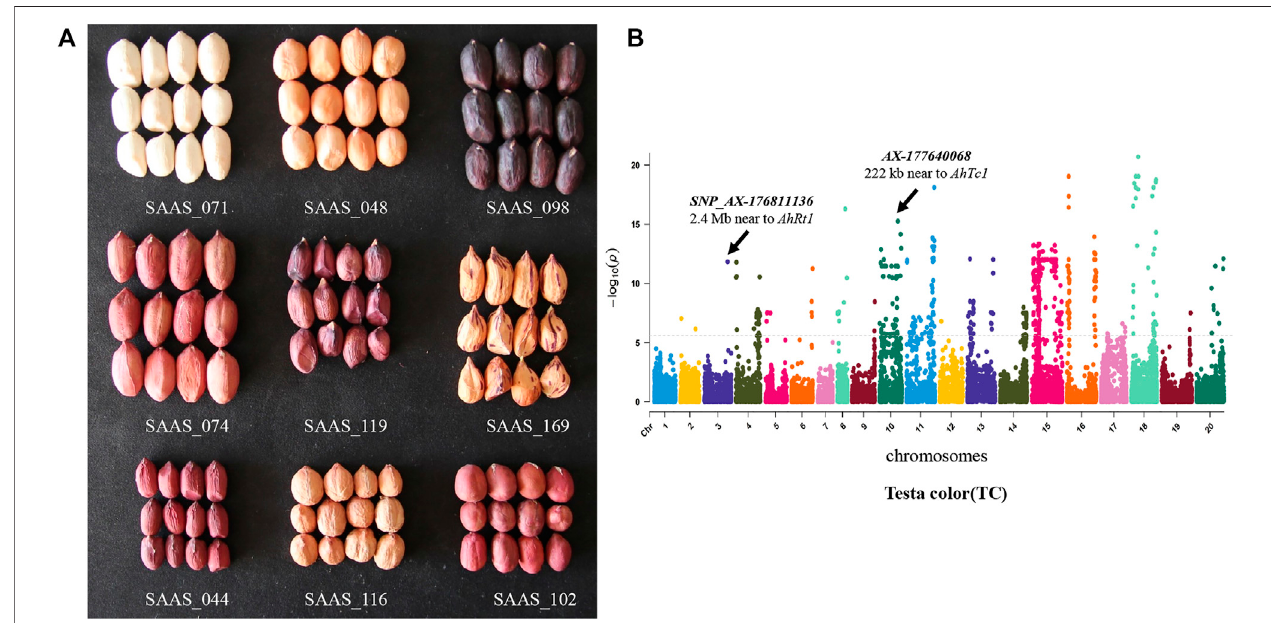
FIGURE 7 | Manhattan plots showing signi fi cant marker-trait associations for testa color of peanut. (A) Peanuts with different testa color, and its (B) GWAS signal. The characteristic analysis for one gene encoding lysosomal cystine transporter is shown below.